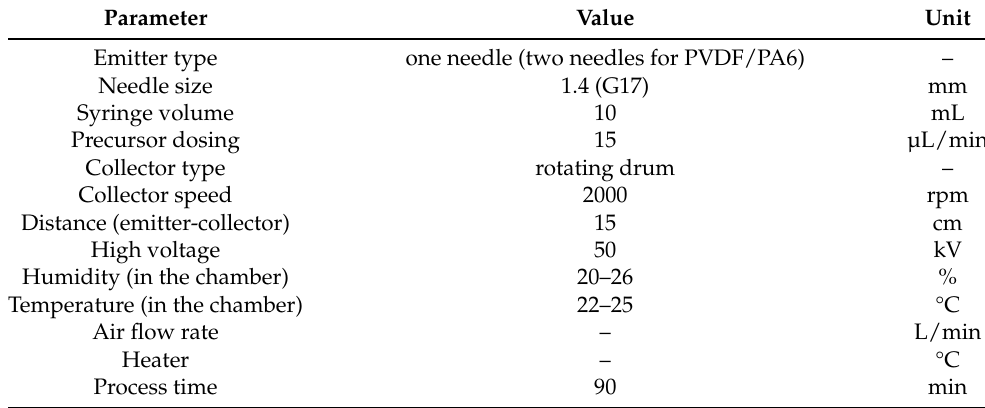
Table 7. Set parameters for spinning production of PVDF, PVDF/PA6, and PA6 on the 4SPIN device. Parameter Value Unit Emitter type one needle (two needles for PVDF/PA6) – Needle size 1.4 (G17) mm Syringe volume mL